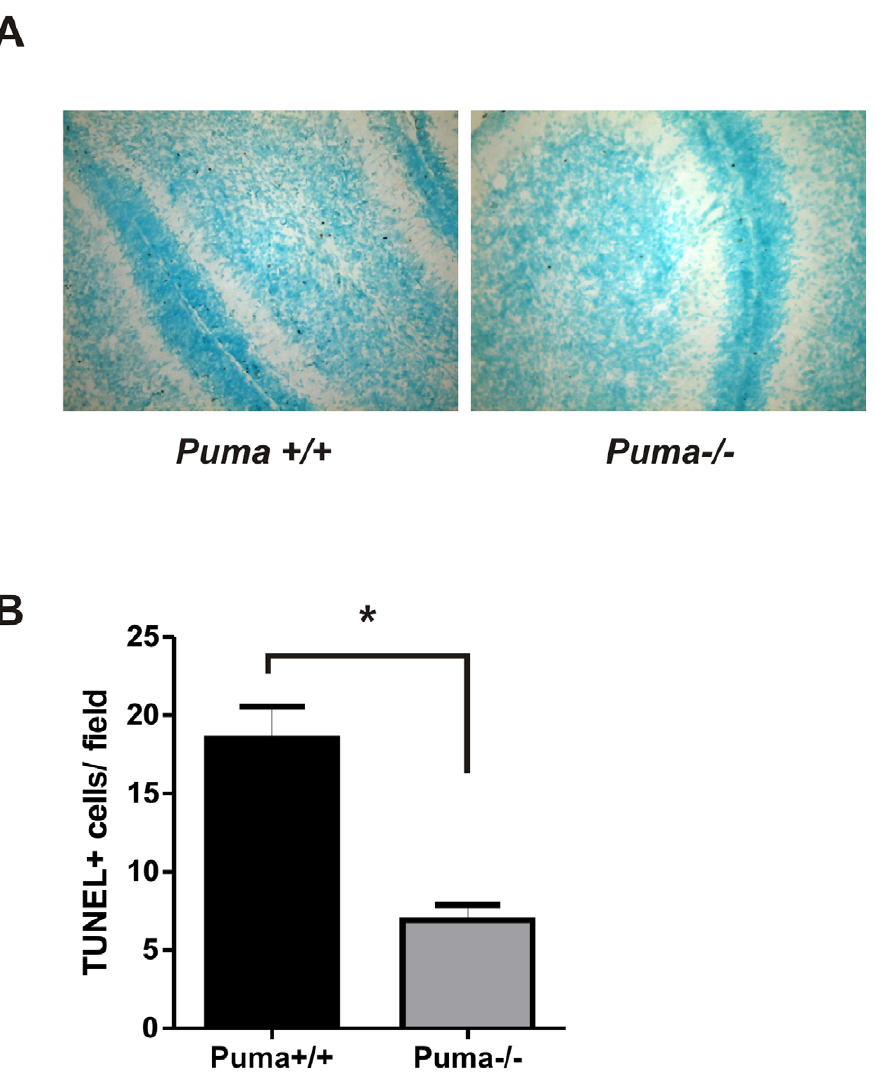
Figure 3. Puma contributes to CGN apoptosis during postnatal development invivo . Sagittal sections from the cerebellum of postnatal day 7 Puma + / + and Puma 2 / 2 mice were TUNEL stained to detect apoptotic cells. A, Representative images showing Tunel labeling (brown DAB + cells) of cerebellar sections from Puma + / + and Puma 2 / 2 mice. B, The mean number of TUNEL positive cells in the internal granule layer (IGL) per field was determined for each animal and the data is presented as the mean + / 2 SEM for Puma + / + and Puma 2 / 2 mouse pups (n=4 mice of